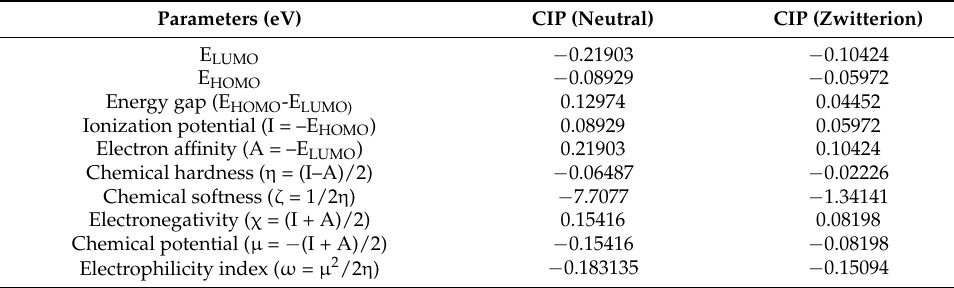
Table 4. Comparison of maximum adsorption capacities of biochar prepared from different sources .